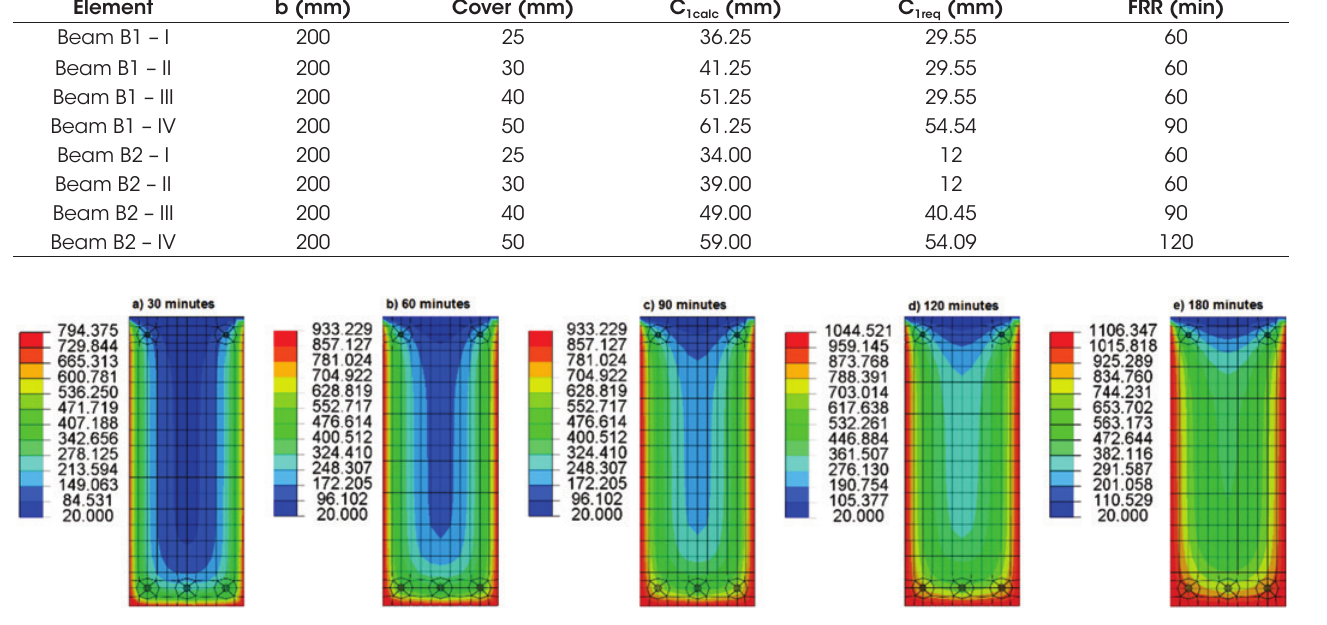
Isotherm B1-I for ratings of (a) 30, (b) 60, (c) 90, (d) 120, and (e) 180 minutes